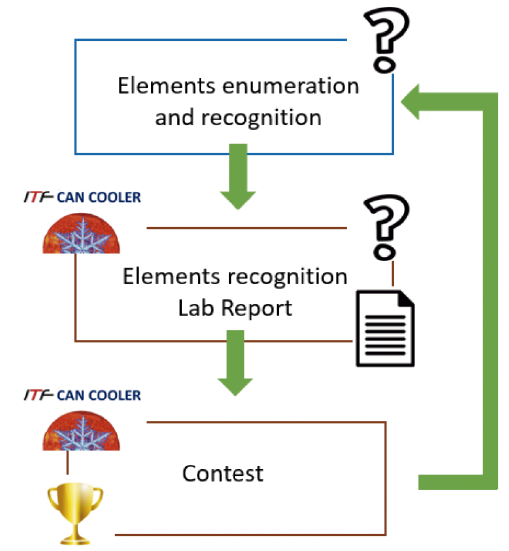
Figure 1. Methodology